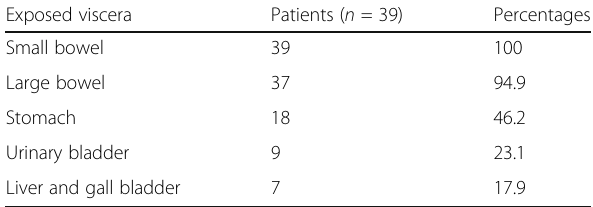
Table 2 Viscera exposed at presentation Exposed viscera Patients ( n =